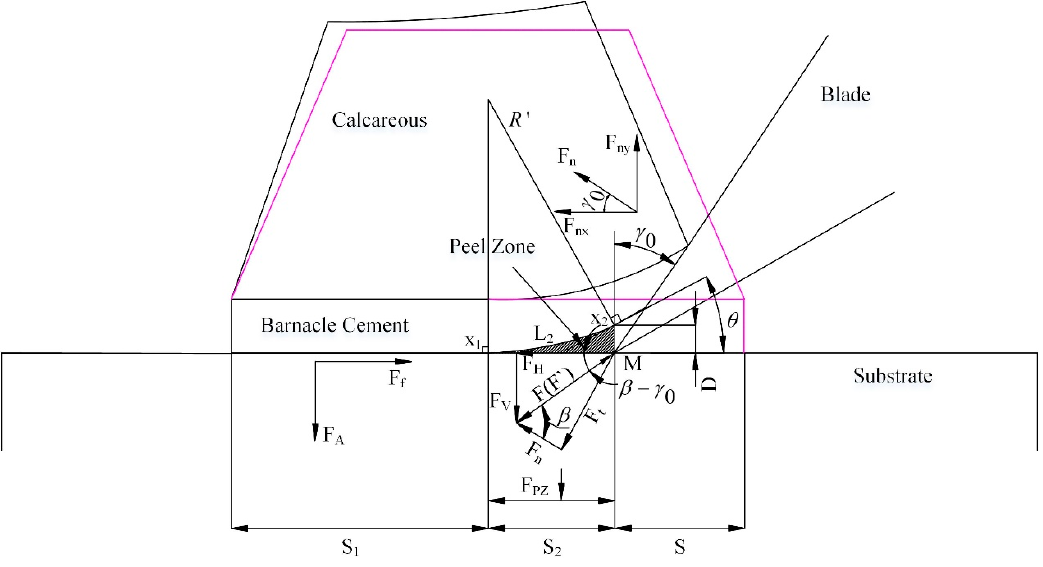
Figure 7. Detailed analysis of the barnacle.